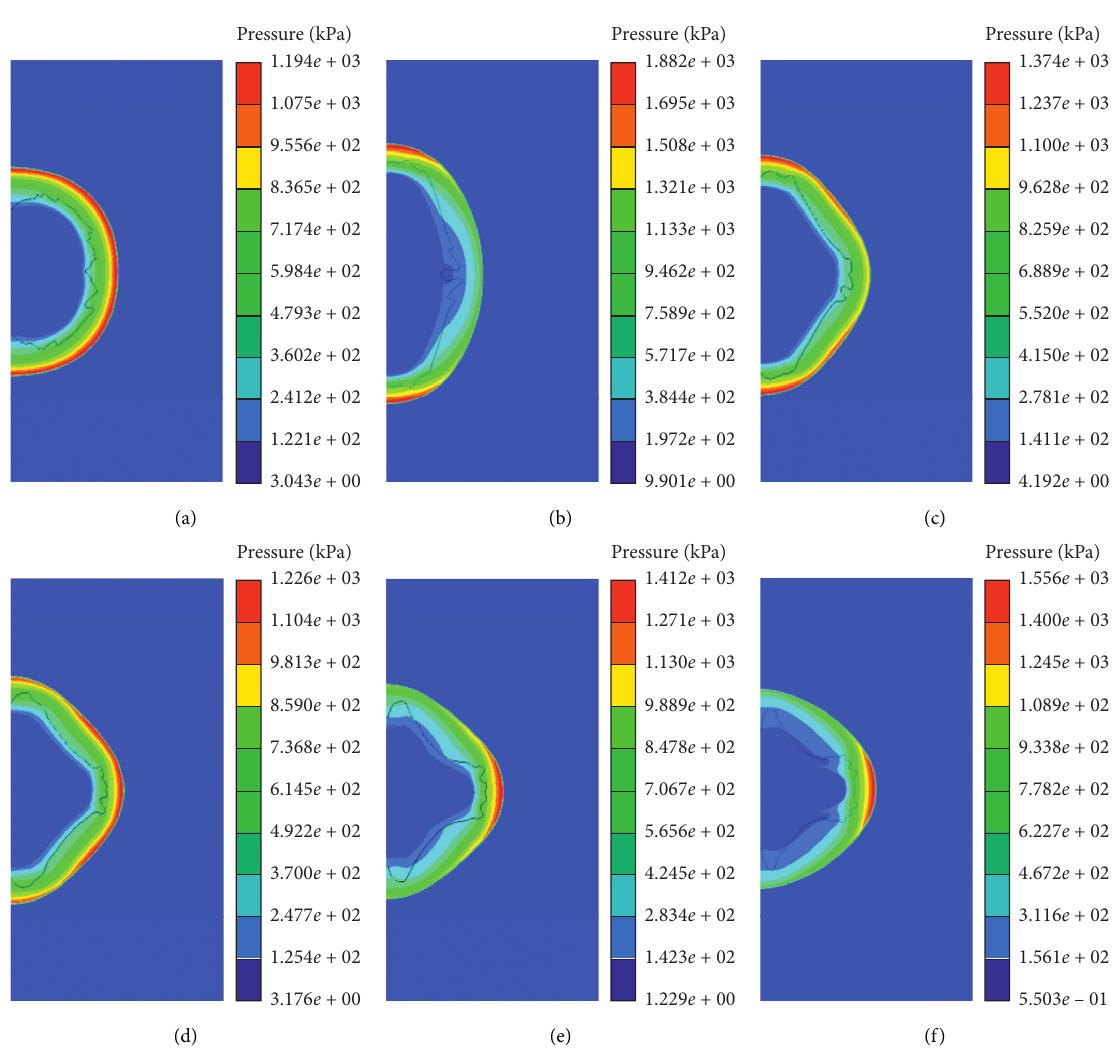
Figure 3: Pressure contours from spherical charge and cylindrical explosives at t � 0.5 ms. (a) Spherical. (b) Cylindrical, L / D � 0.2. (c) Cylindrical, L / D � 0.6. (d) Cylindrical, L / D � 1.0. (e) Cylindrical, L / D � 2.0. (f) Cylindrical, L / D �